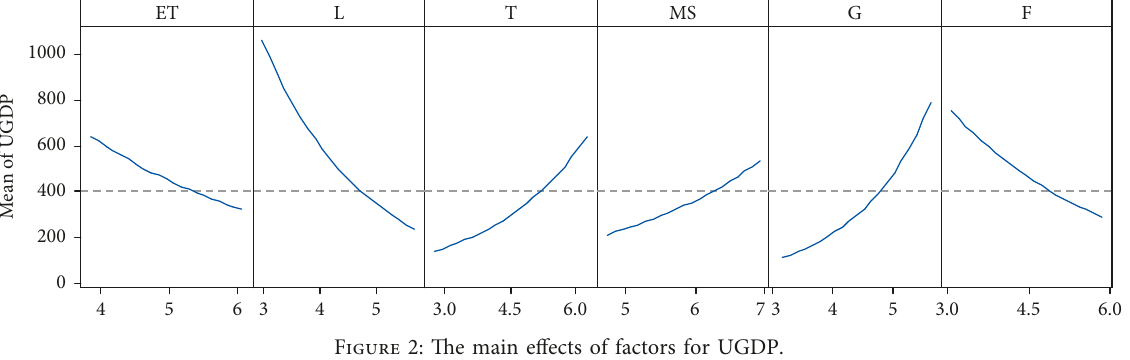
Figure 2: The main effects of factors for UGDP.